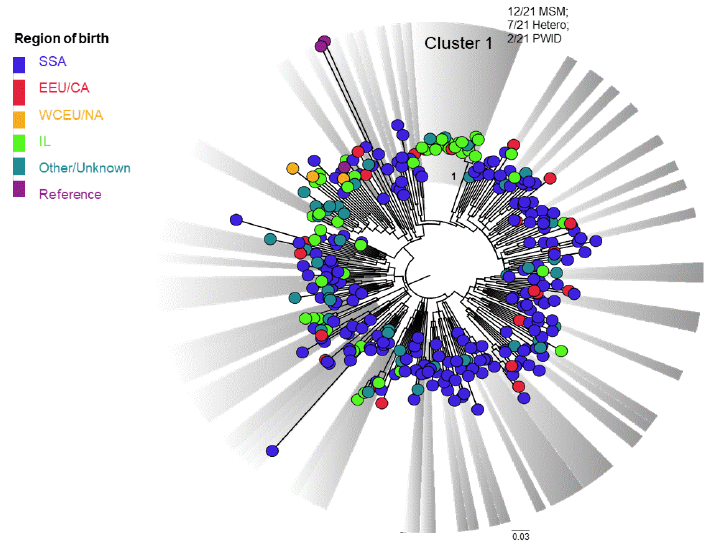
Figure 2. Phylogenetic analysis of subtype C sequences, N = 313. A phylogenetic tree of the pol region of subtype C sequences from 313 HIV-1 patients using the maximum likelihood (ML) with GTR + G + I model is shown. Included are three reference sequences (Table S1). The tree was visualized in Fig Tree version 1.4.4. Clusters (bootstrap values > 0.7) are colored in grey. The regions of origin are colored as follows: SSA (Sub-Saharan Africa) in navy blue; EEU/CA (Eastern Europe and Central Asia) in red; WCEU/NA (Western and Central Europe and North America) in orange; IL (Israel) in light green; other/unknown birthplace in turquoise; reference sequences in purple. PWID—people who use injection drug; MSM—men who have sex with men; HETERO—heterosexual contacts.